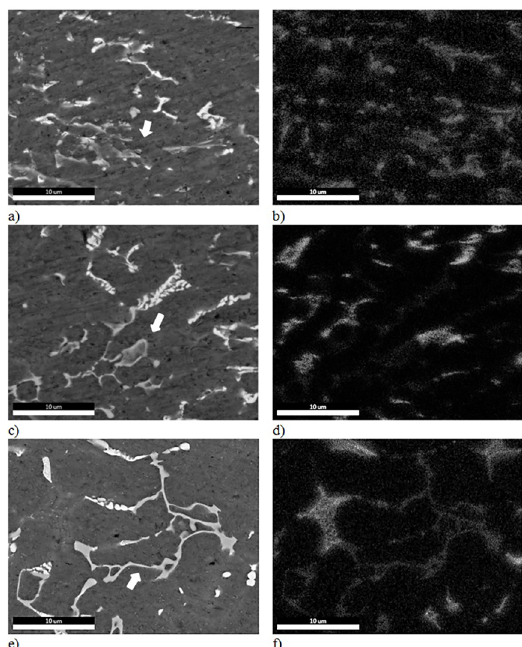
Figure 5. BSE images of the step 1 (a), step 3 (c) and step 6 (e). Silicon ESD map of the the step 1 (b), step 3 (d) and step 6 (f) of ingots of Al-5Si3Cu solidified in the six-stepped cylindrical steel mold. The arrows point to the α